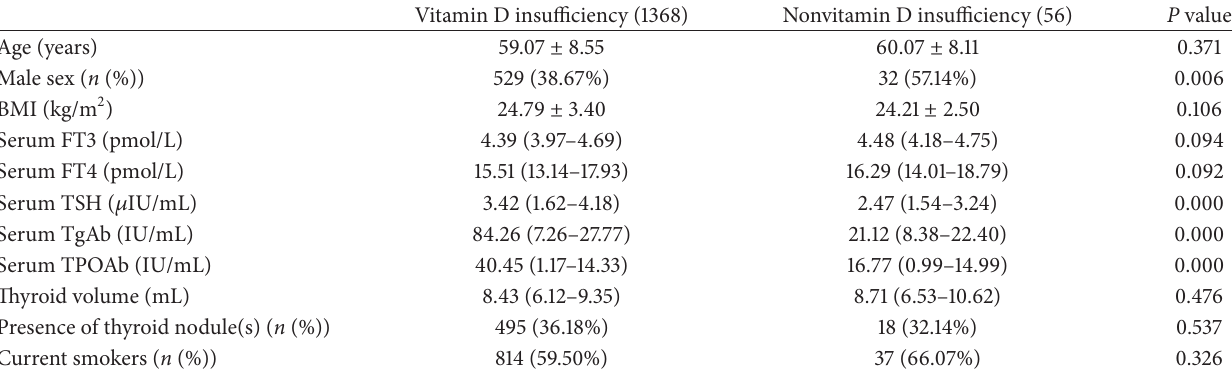
Table 2: Comparison of clinical and laboratory characteristics based on vitamin D